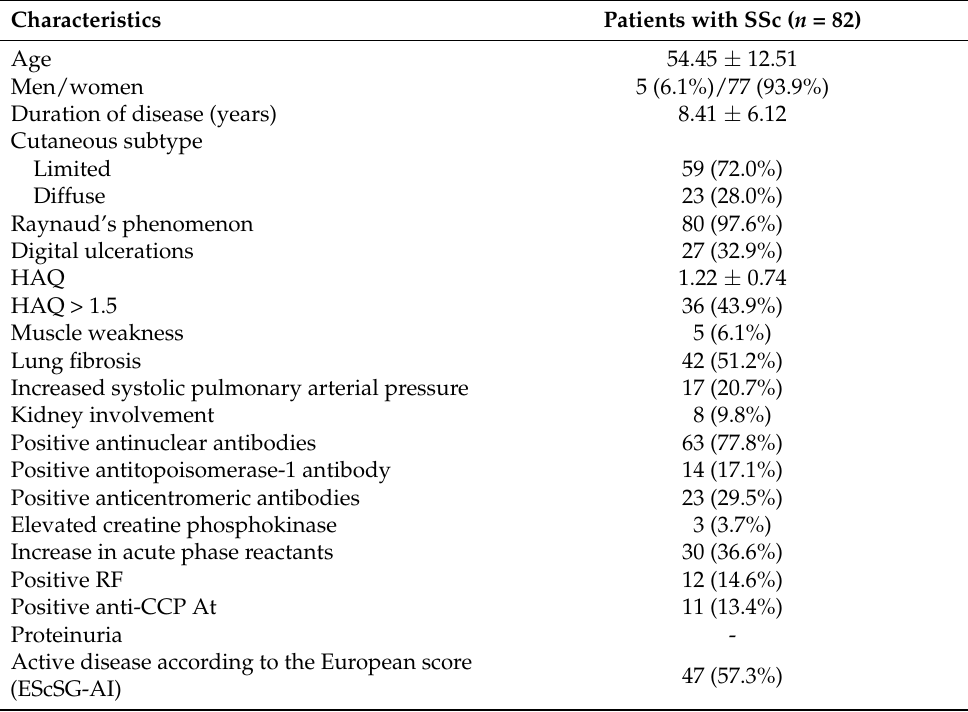
Table 1. Characteristics of patients with systemic sclerosis (SSc).